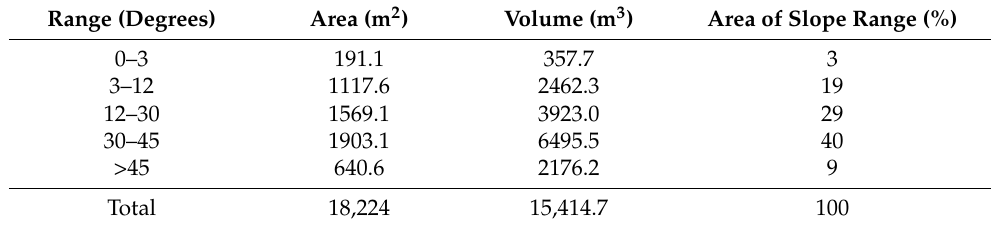
Table 1. Area eroded by range of